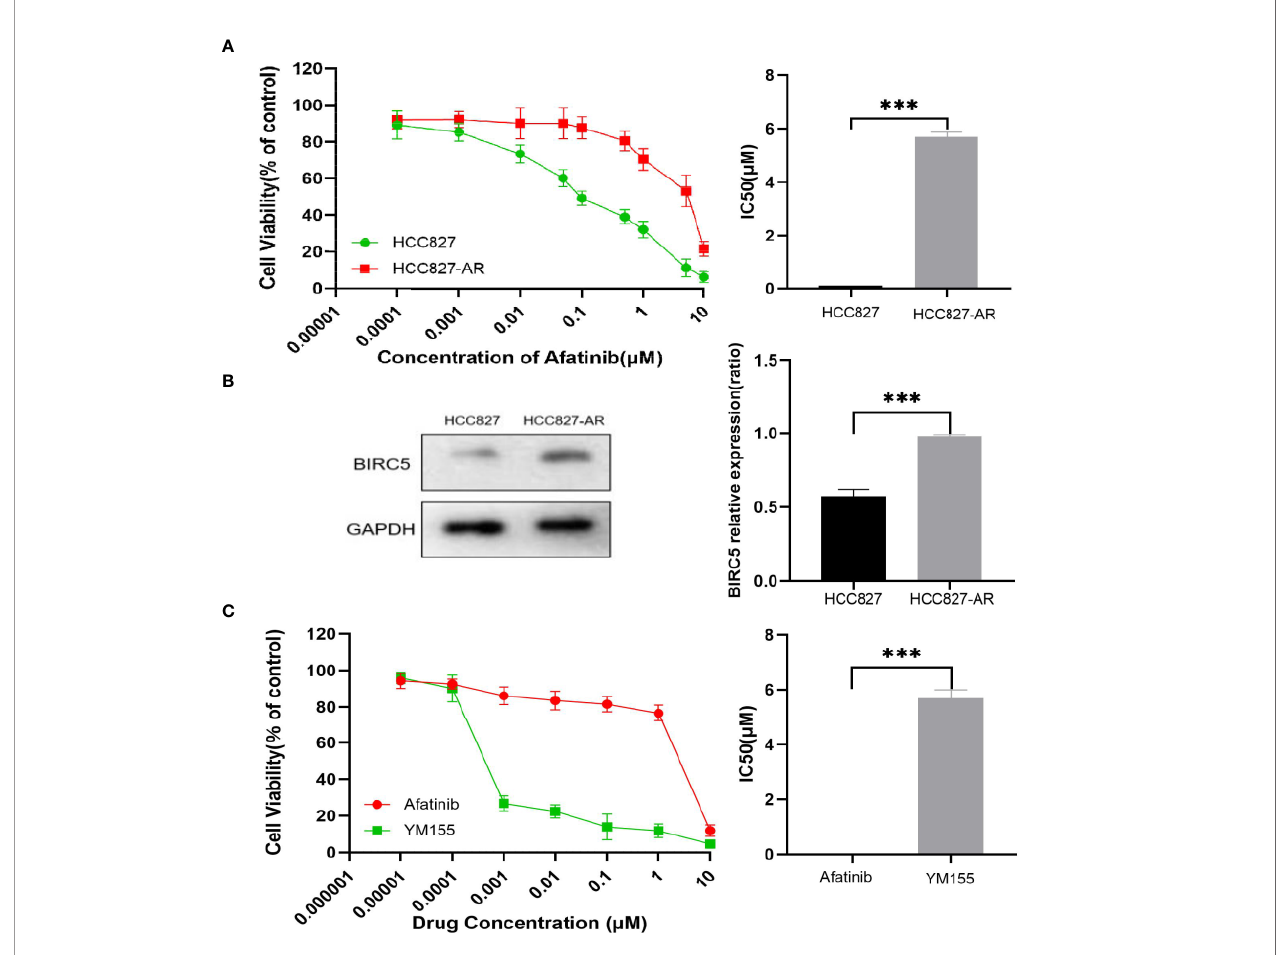
FIGURE 13 | Induce and detect HCC827 and HCC827-AR cells. (A) HCC827 and HCC827-AR cells of cell viability assays are shown. (B) Protein expression levels of BIRC5 in HCC827 and HCC827-AR cells. (C) Effects of afatinib and YM155 on HCC827-AR cells as observed via cell viability assays are shown. ***p <